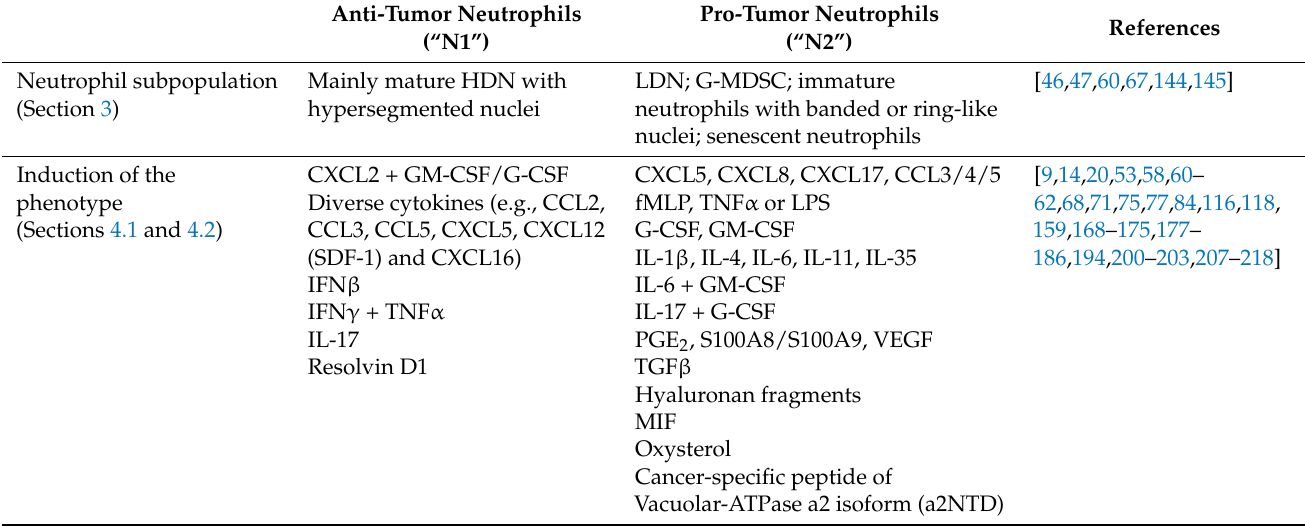
Table 3. Characteristics of anti- and pro-tumor neutrophils. The table emphasizes some specific traits that have been attributed to the activation and function of anti- versus pro-tumor neutrophils. Concerning the heterogeneous “N2” population, some of the traits are related to the immature LDNs (labeled with *) or the senescent mature neutrophils (labeled with **). Most studies on “N2” neutrophils have not discerned between the different “N2” subpopulations, and thus the general concept is provided. The section number in which the subject is discussed is mentioned in